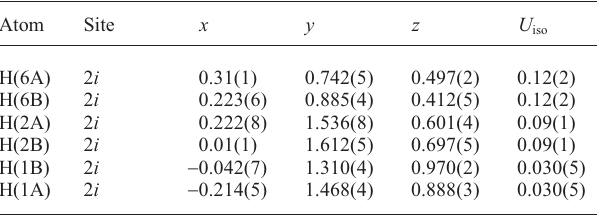
Table 2. Atomic coordinates and displacement parameters (in Å 2 )